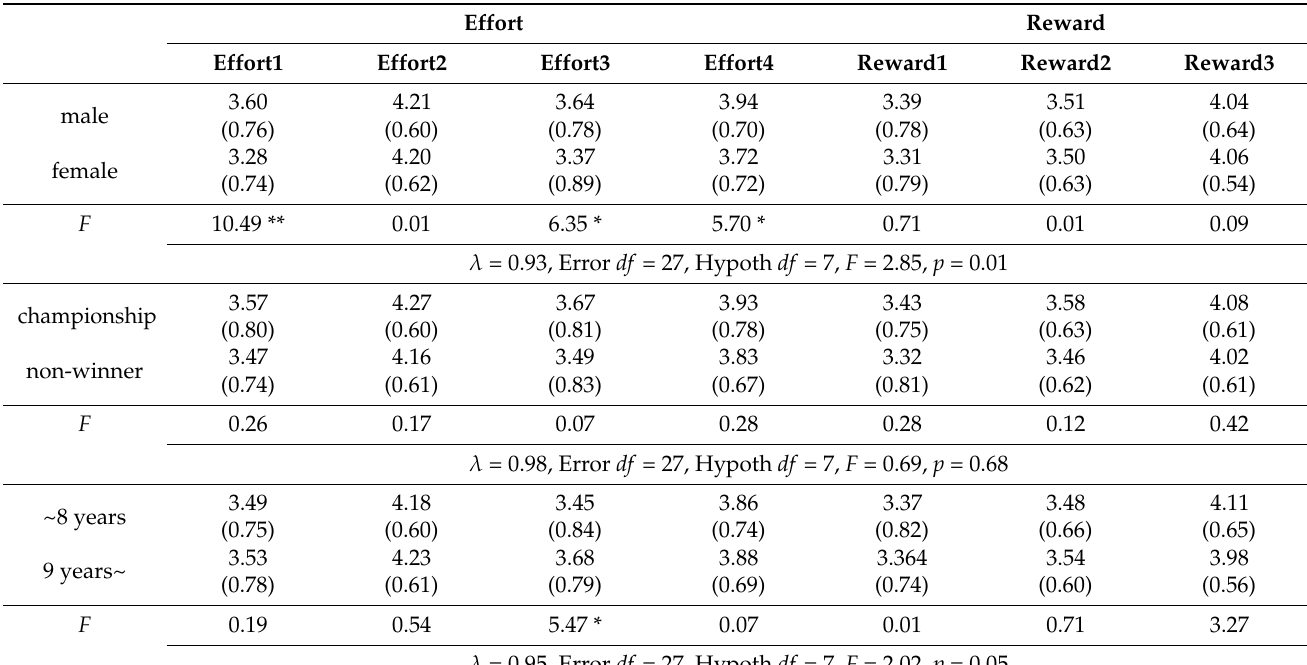
Table 5. MANOVAs of effort and reward by